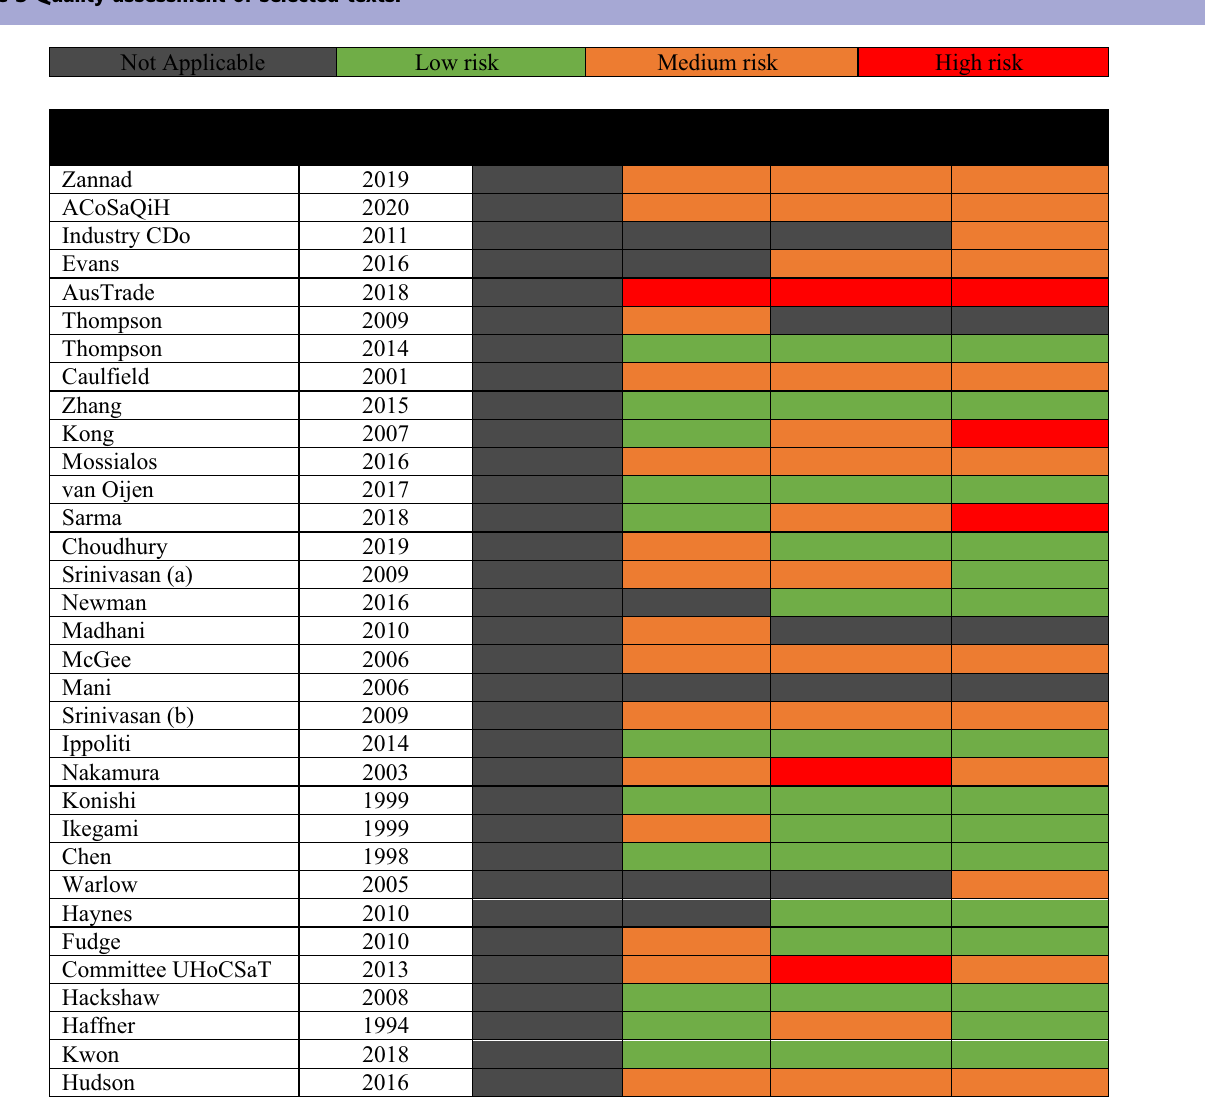
Table 5 Quality assessment of selected